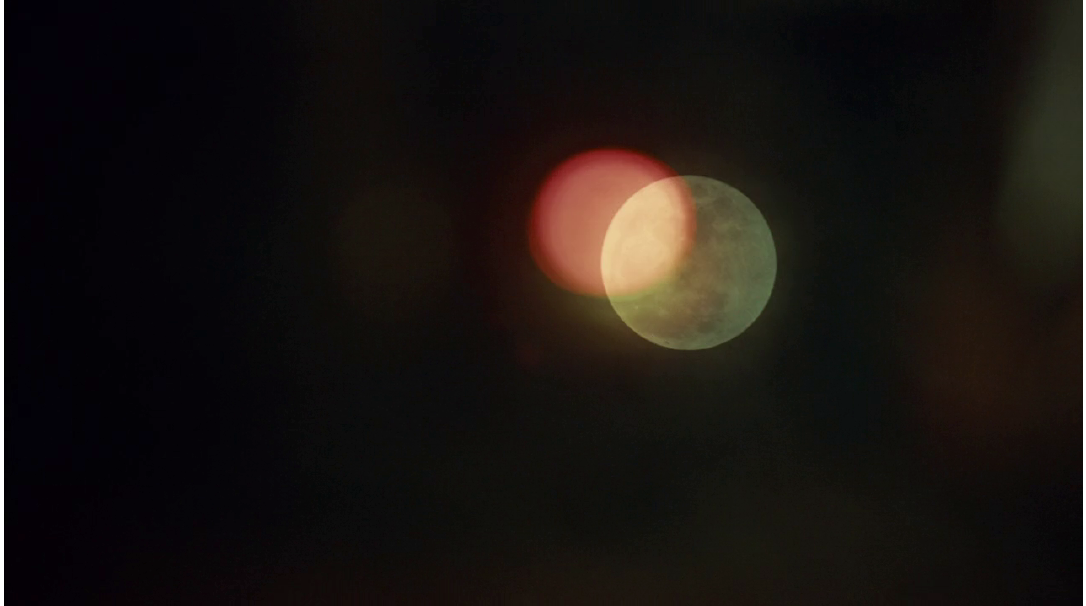
Figure 6. The rear light of Hannibal’s bike is match-cut with a full moon. This visual codes the pairing of opposites, or, to use Jung’s description, the “marriage” of consciousness and unconsciousness, symbolized by the closeness of Sol and Luna (106); it also foreshadows/foregrounds the theme of love between Hannibal and Will and, alchemically speaking, announces the possibility of transitioning from the albedo to rubedo stage. Worth recalling is Zeri’s comment about Venus’s (more likely, Isis’s) medallion in Primavera , in which “the flame of the fire of love” is “captured by the ruby set into the pendant” (Zeri 12). Screencap from Hannibal , season 3, episode 1,